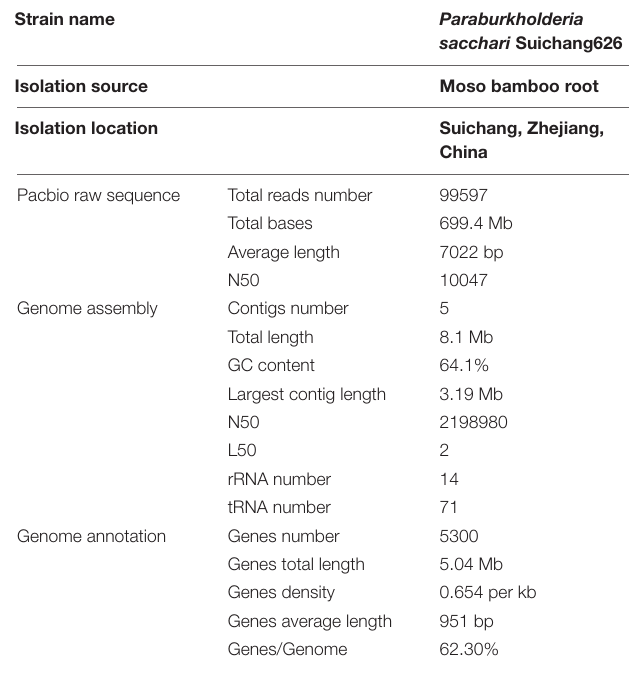
TABLE 1 | Genome information of Paraburkholderia sacchari